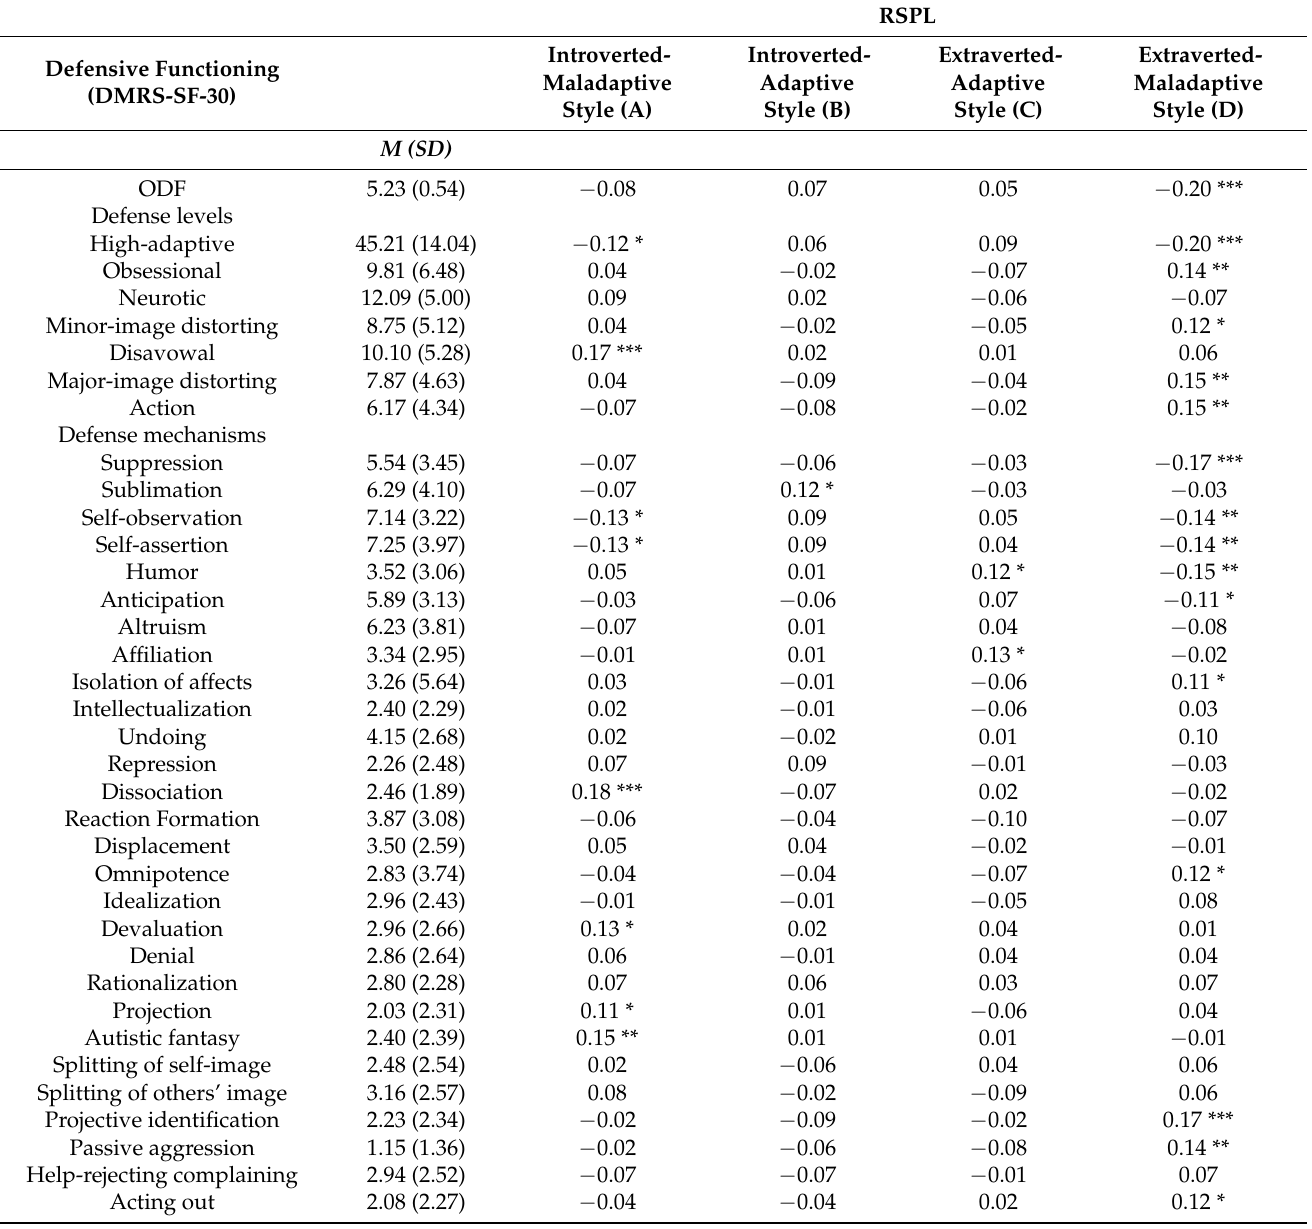
Table 3. Bivariate Correlations Between Response Styles to the COVID-19 Pandemic and